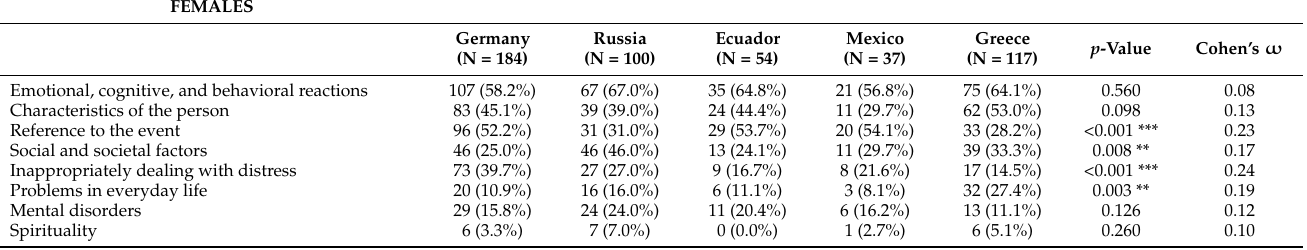
Table 5. Percentage of participants mentioning the second-order theme according to the thematic analysis presented by current country of residence for female (upper table) and male (lower table) participants. p -values were calculated with Fisher’s exact